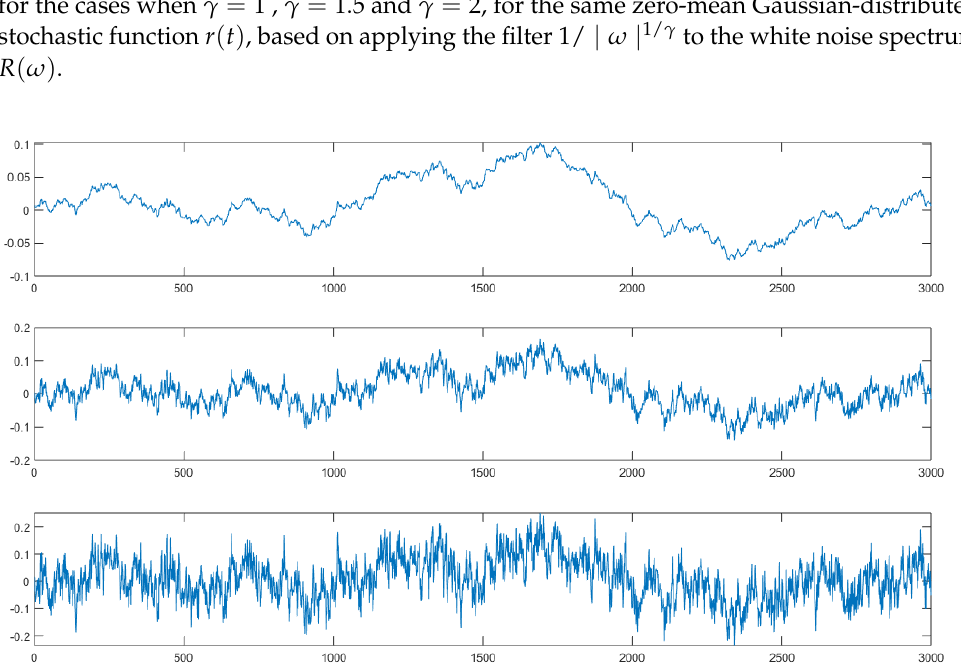
Figure 7. Comparisons of a financial signal simulation based on the RWH when γ = 1 (above), the FMH when γ = 1.5 (centre) and the EMH when γ = 2 (lower